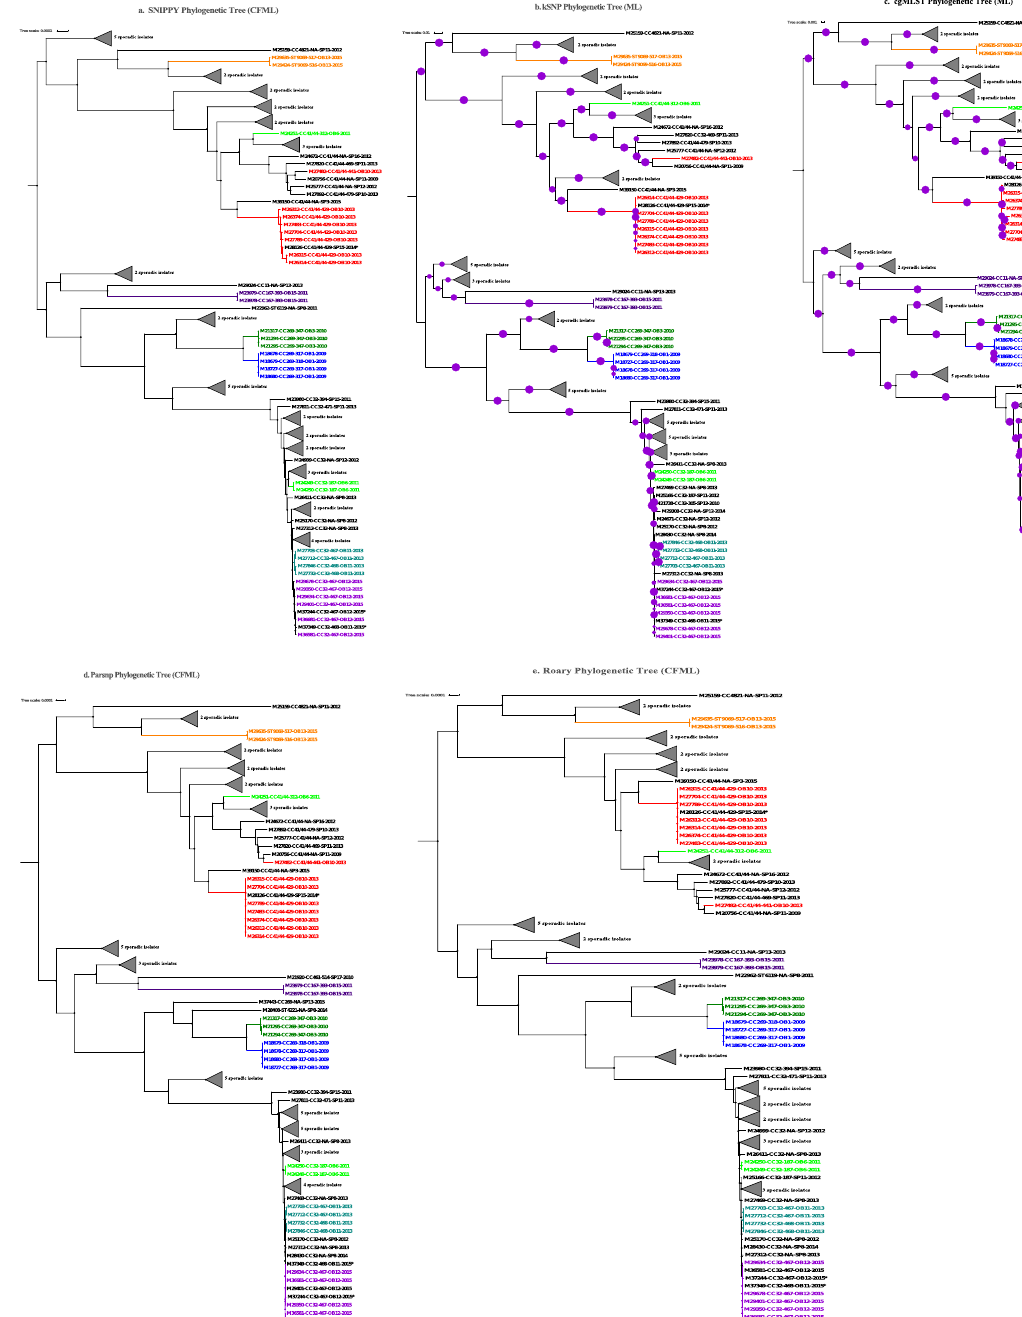
Figure 1. Phylogenetic trees generated using different WGS analysis methods for NmB outbreak and sporadic isolates, 2009–2015. ( a ) SNIPPY Phylogenetic Tree reconstructed from a whole genome core alignment generated based on reference-based short read mapping and corrected for recombination using ClonalFrameML. ( b ) kSNP Phylogenetic Tree, a maximum likelihood (ML) phylogenetic tree generated using RaXML from the core SNP alignment generated by kSNP. ( c ) cgMLST Phylogenetic Tree, an ML tree created from the concatenated core gene alignment using RaXML. ( d ) Parsnp Phylogenetic Tree reconstructed from a whole genome core alignment generated using Parsnp and corrected for recombination using ClonalFrameML. ( e ) Roary Phylogenetic Tree generated from the concatenated core gene alignment; recombination was corrected using ClonalFrameML. Purple circles represent branch-level bootstrap support out of 100 bootstrap estimates. The circumference of a circle is proportional to the bootstrap support.